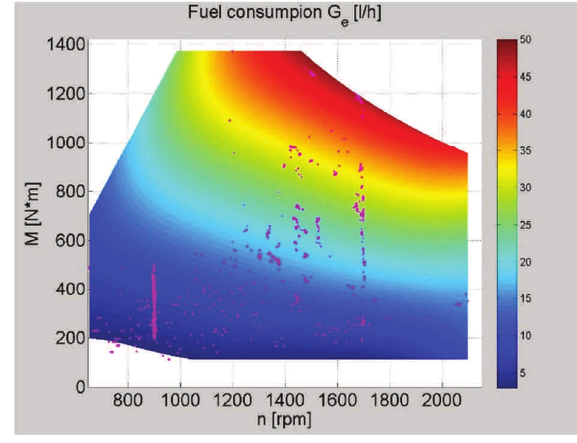
Fig. 4. Characteristics obtained from operational data: static state duration 0.5 s; derivative limits: 20 N ∙ m/s, 20 rpm/s